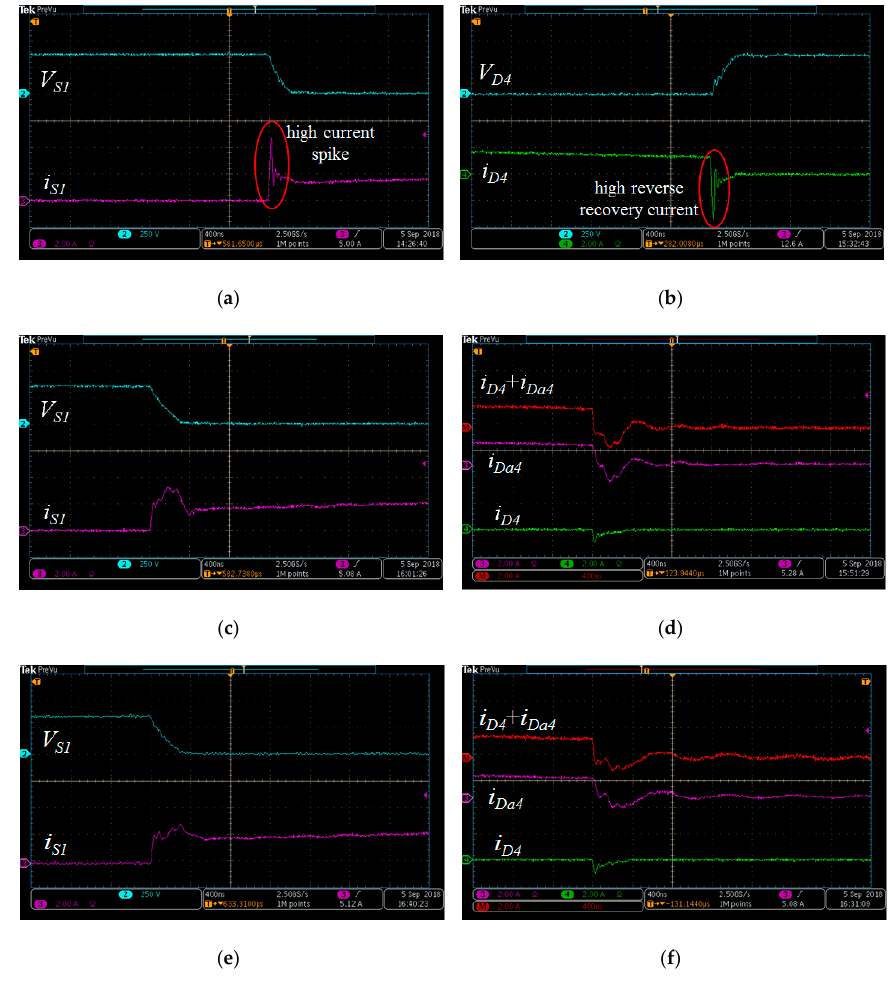
Figure 13. Experimental waveforms of the conventional inverter and the proposed inverter: ( a ) V S1 and i S1 in the conventional inverter; ( b ) V D4 and i D4 in the conventional inverter; ( c ) V S1 and i S1 with L k = 5 µH in the proposed inverter; ( d ) i D4 + i Da4 , i Da4 and i D4 with L k = 5 µH in the proposed inverter; ( e ) V S1 and i S1 with L k = 15 µH in the proposed inverter; ( f ) i D4 + i Da4 , i Da4 and i D4 with L k = 15 µH in the proposed inverter.